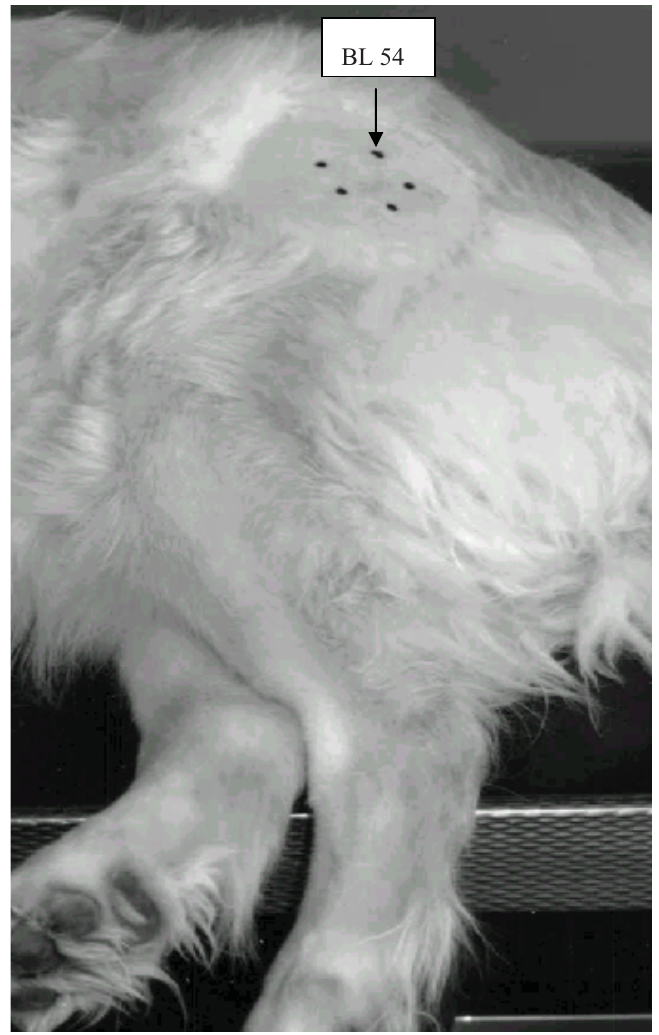
Figure 1. The acupuncture points GB 29, GB 30 and BL 54 together with two trigger-points marked with Indian ink in the hip area.